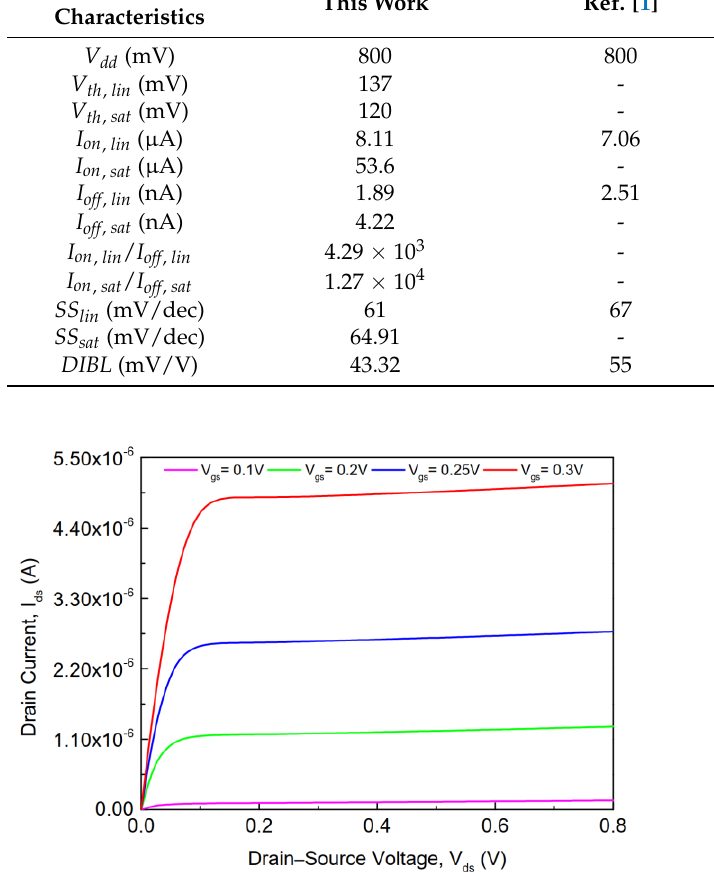
Figure 3. Output I – V curves of the investigated FinFET model with different gate – source voltages. To evaluate the SCEs, the subthreshold slope ( SS ) and drain-induced barrier lowering ( DIBL ) are extracted as follows [4,11]